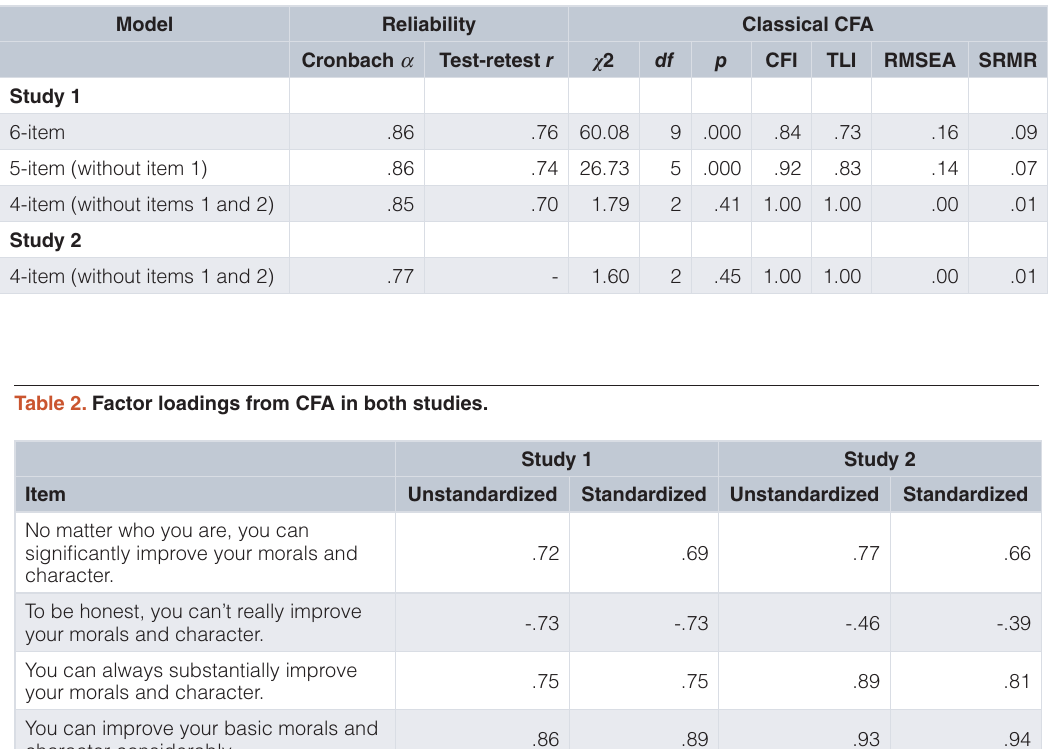
Table 1. MGM measure English reliability check and confirmatory factor analysis (CFA) results.